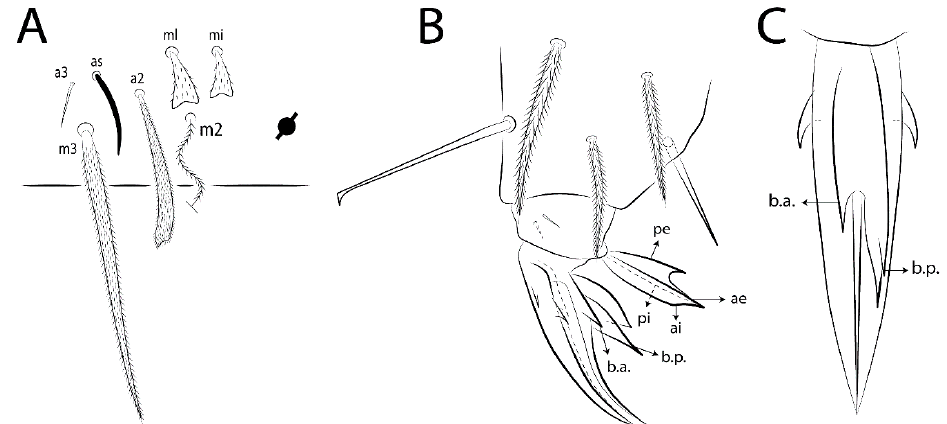
Figure 7. Pseudosinella guanhaensis . ( A ) Abd II central chaetotaxy; ( B ) distal tibiotarsus and empodial complex III (anterior view); and ( C ) unguis (inner view).